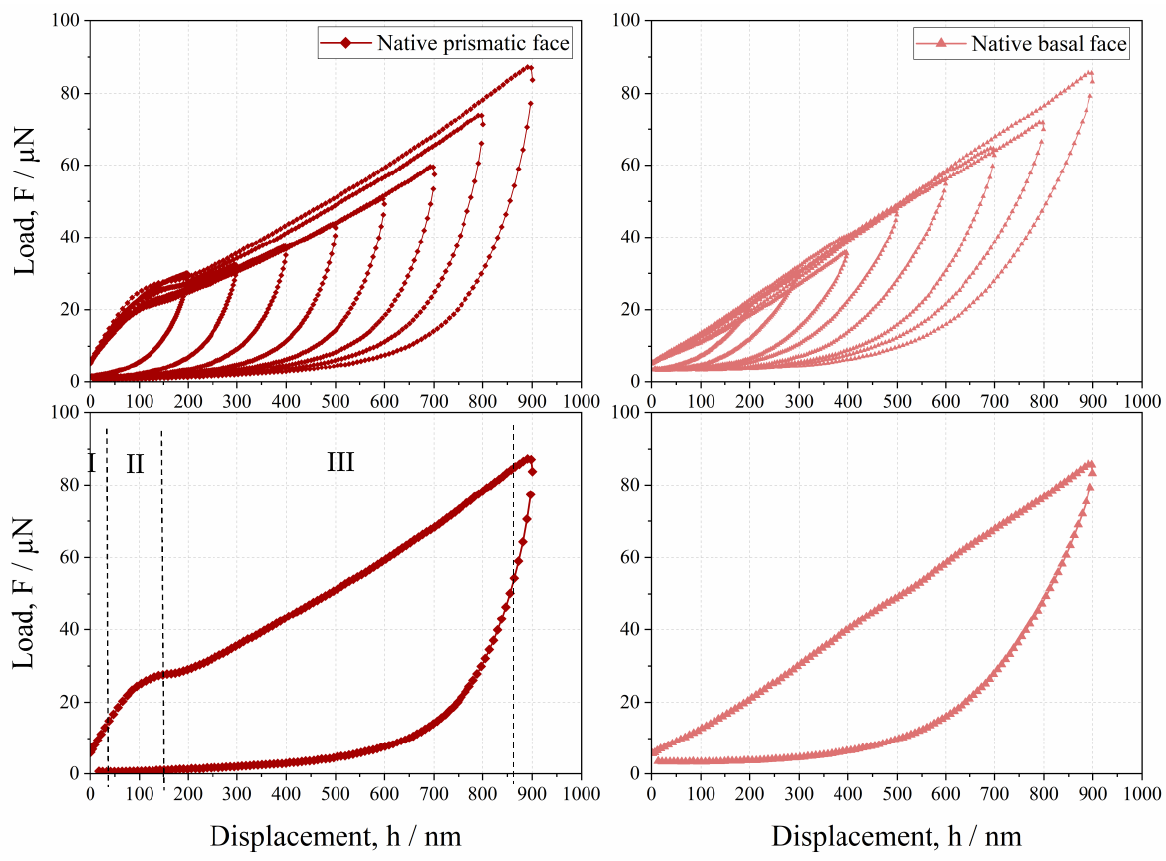
Figure 9. Representative force–displacement curves of native prismatic ( left ) and basal ( right ) crystal faces. Bottom: single curves at a penetration depth of 900 nm are presented for better resolution of the mechanical response.